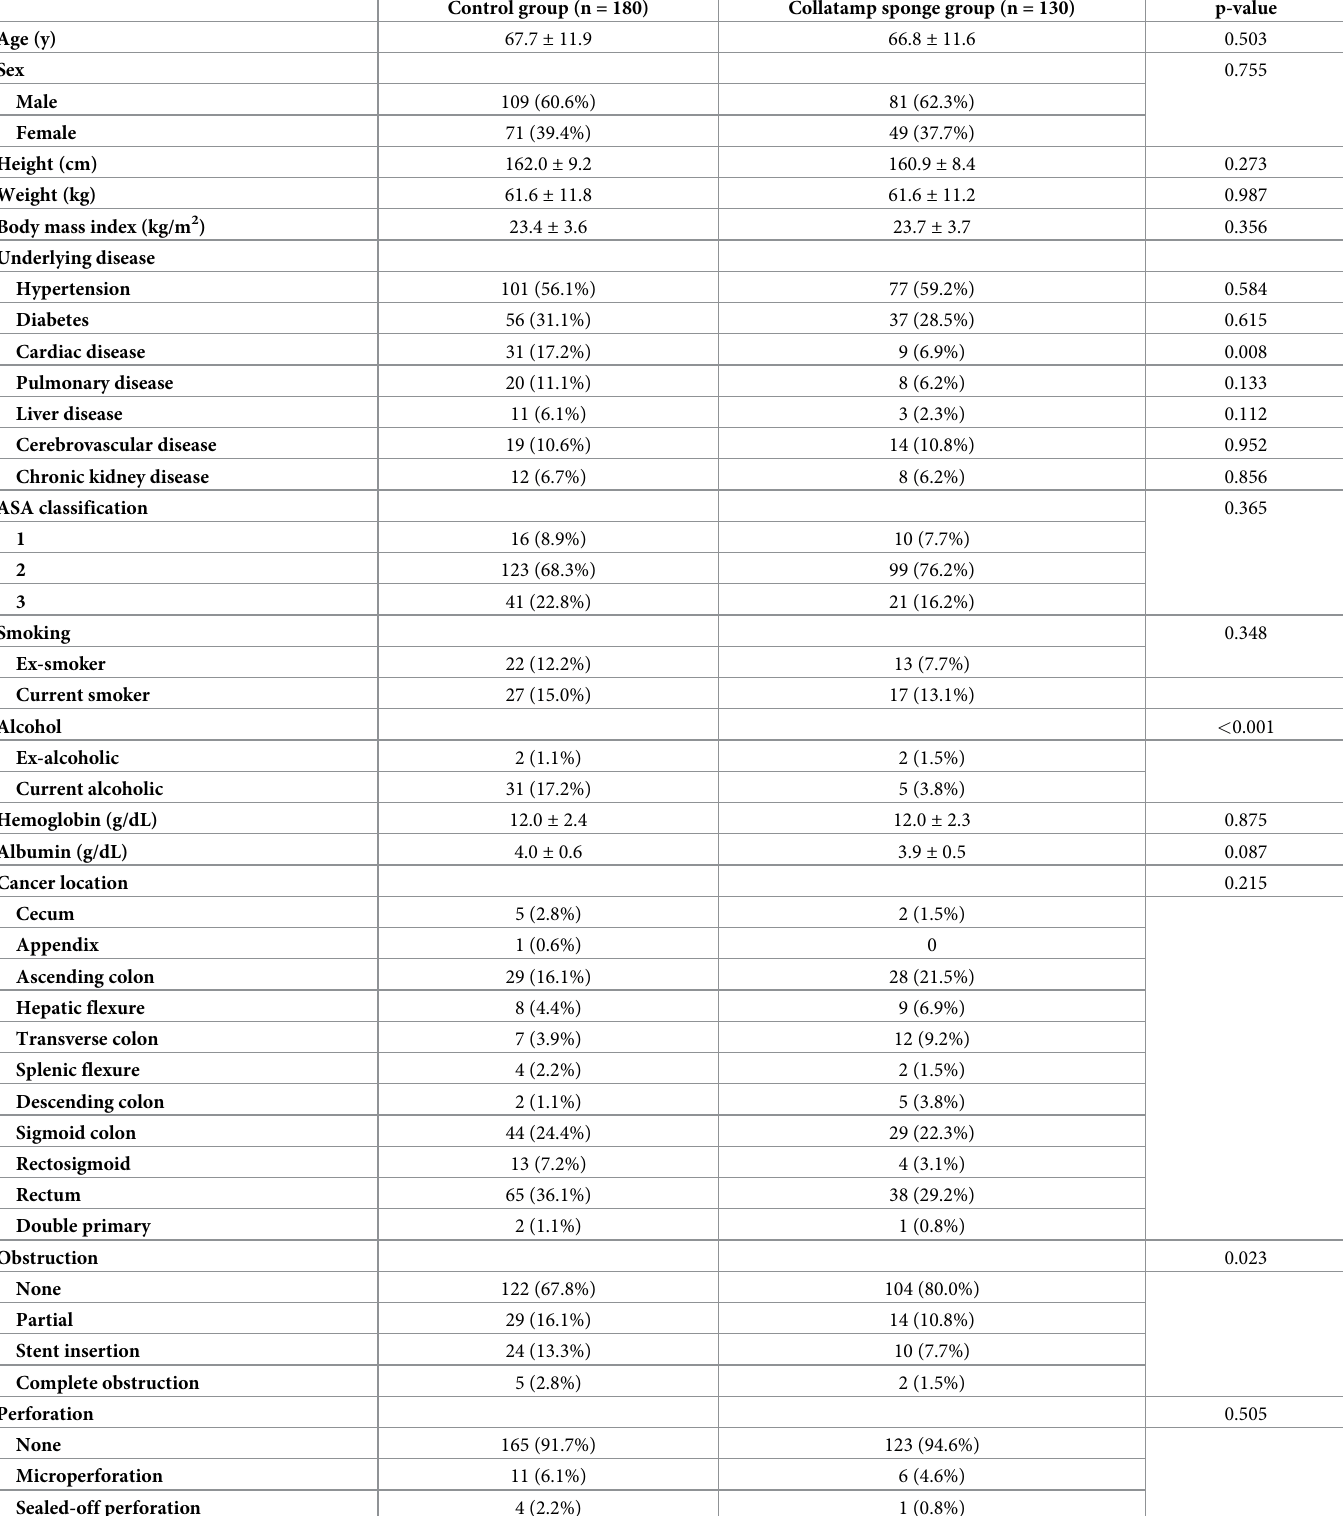
Table 1. Patients’ characteristics before propensity